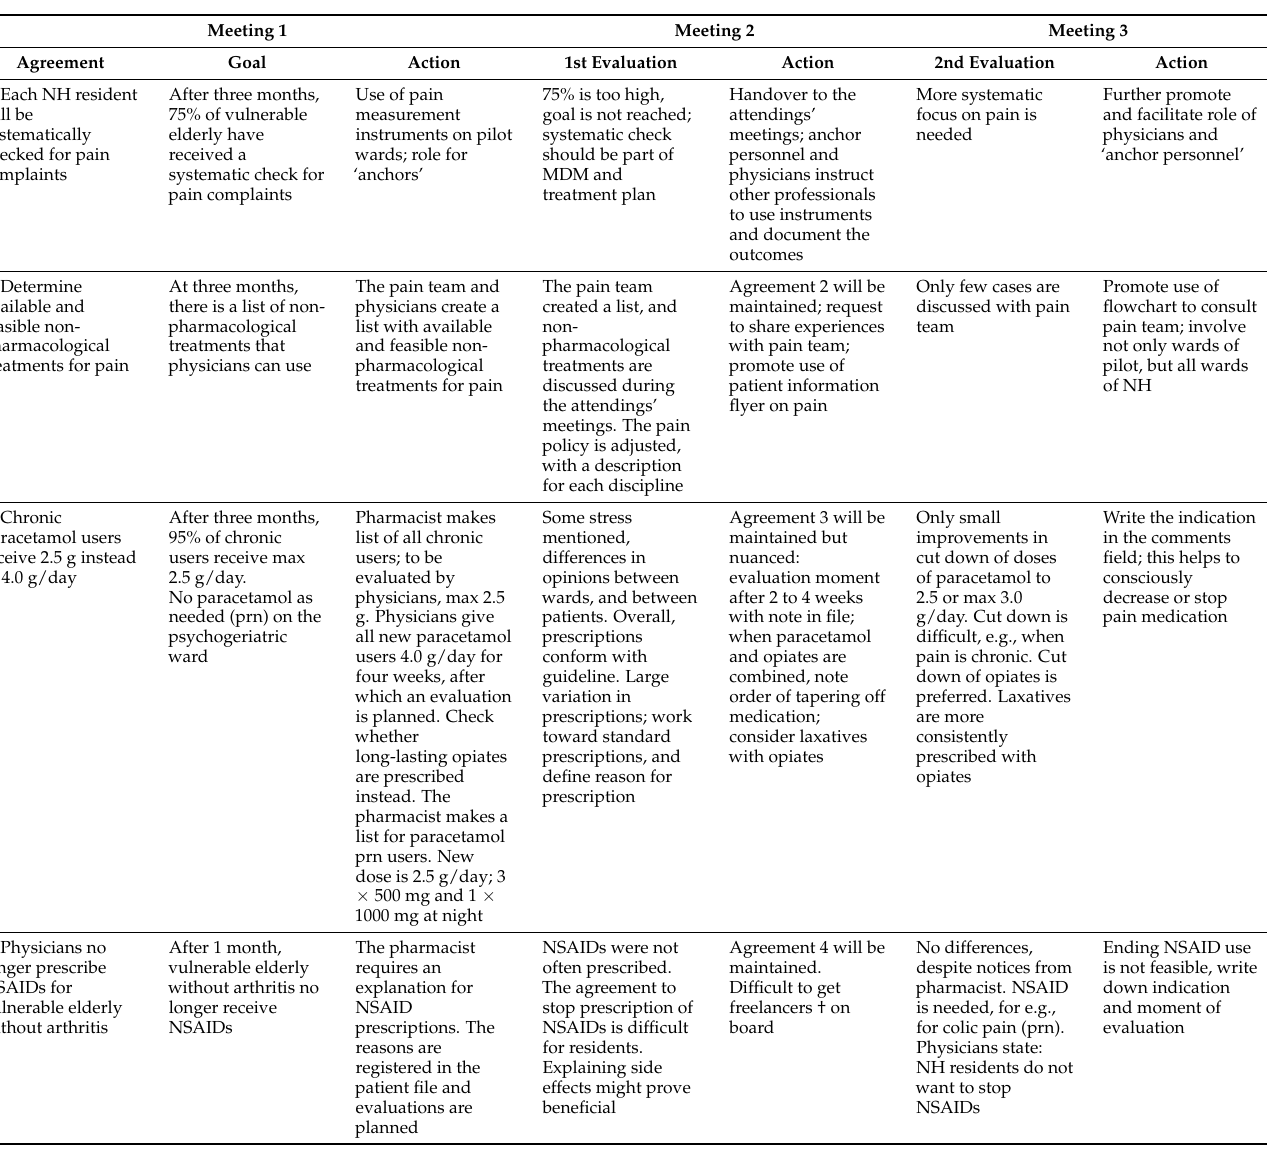
Table 3. Summary of pharmacotherapy audit